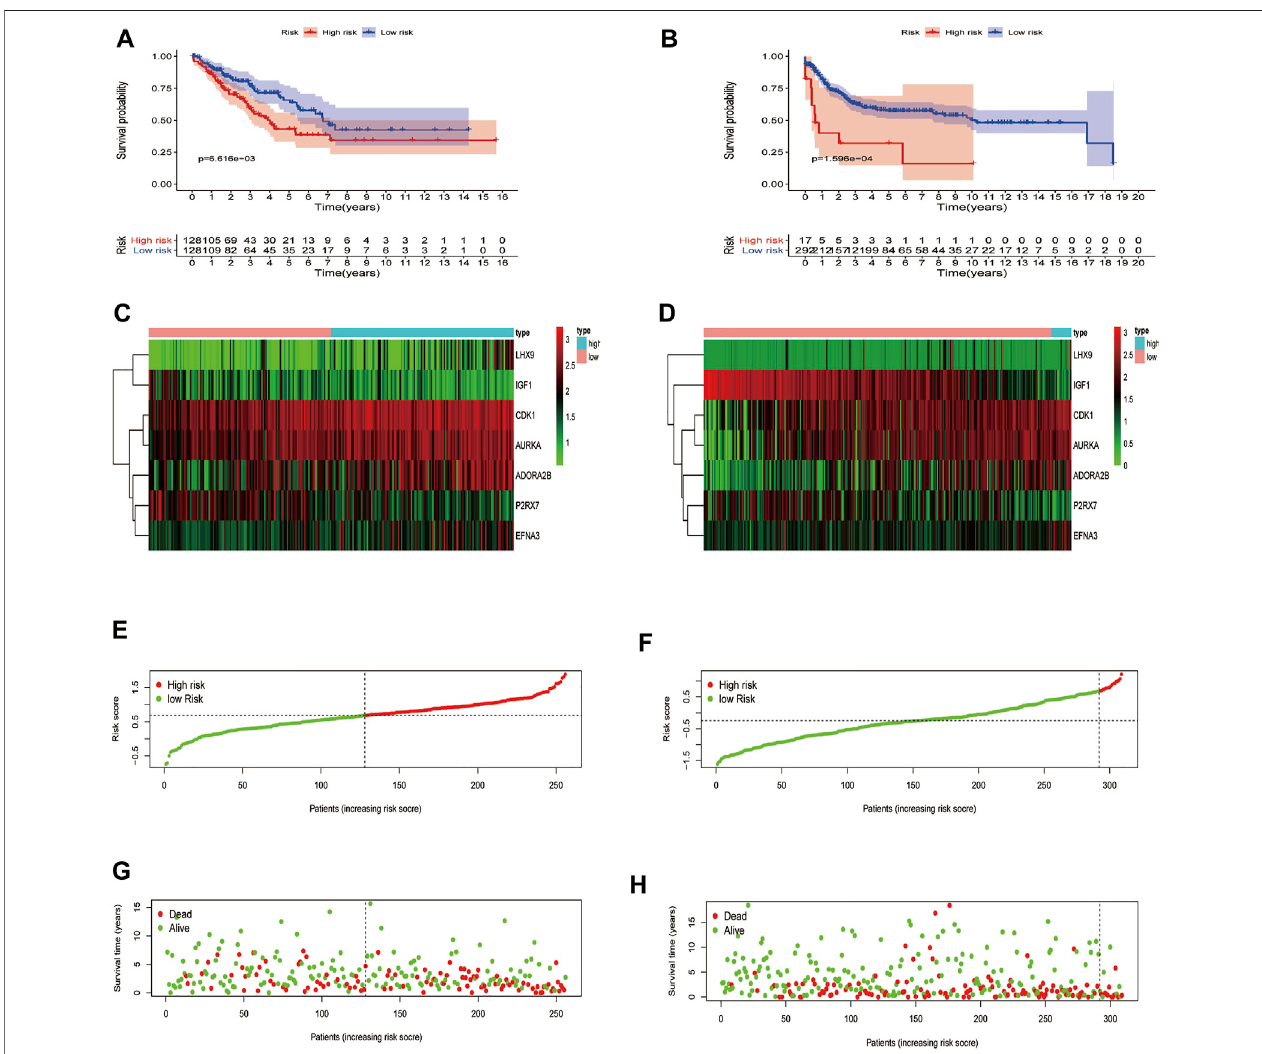
FIGURE 5 | Risk signature development. Survival analysis of the training (A) , test (B) . The upper part demonstrates the KM(Kaplan-Meier) curves for the high and low risk groups. The number shows the living patients with time in the two groups. Differences in gene expression level between two groups, risk distribution of per samples, and relationship between survivalstatus and survivaltimes, training set (C,E,G) , test set (D,F,H) . Thedark lineshows thecut-off point dividing thetwogroups.